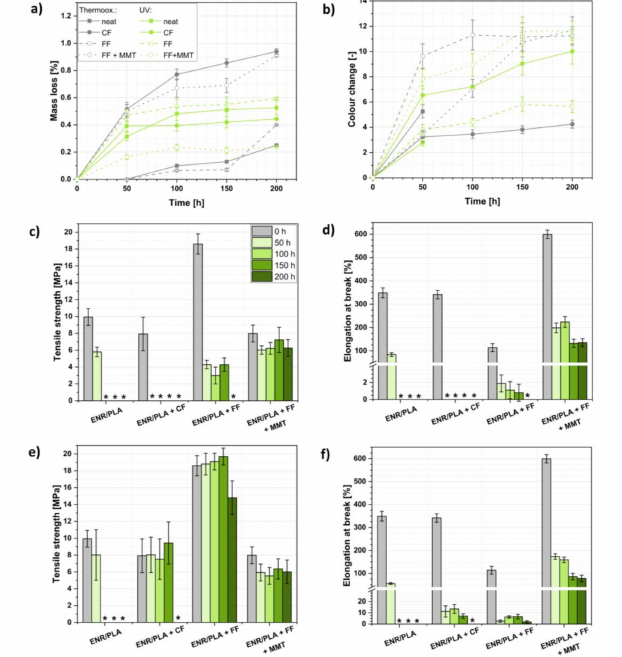
Figure 3. Investigation of the ENR/PLA blends’ properties before and after the accelerated aging processes: ( a ) mass loss during thermo-oxidative and UV aging, ( b ) color change during thermo- oxidative and UV aging, ( c ) tensile strength changes and ( d ) elongation at break variations during thermo-oxidative aging, ( e ) tensile strength changes and ( f ) elongation at break variations during the UV aging. * sample too brittle to be examined with the selected method; the measurement was